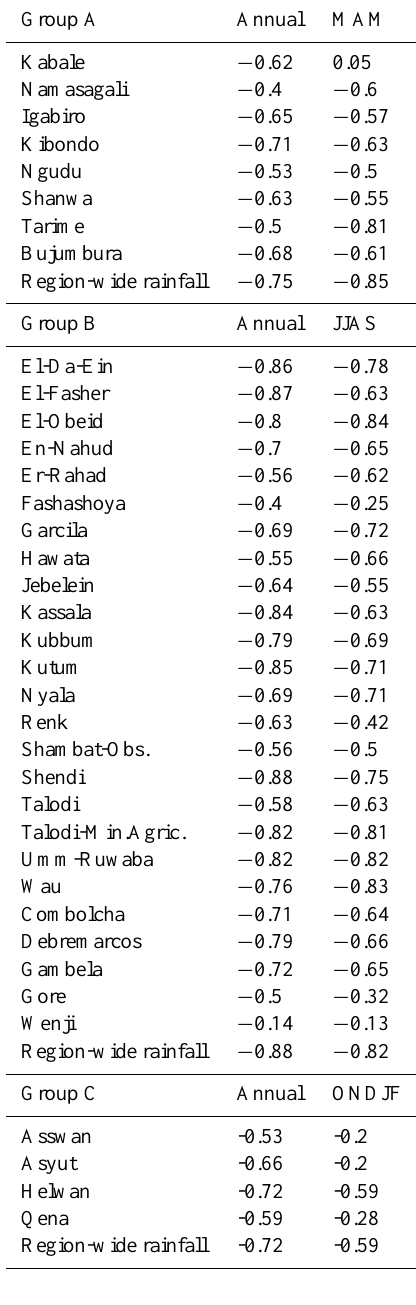
Table 3. Correlation between rainfall and SLP differences taken at locations shown in Fig.